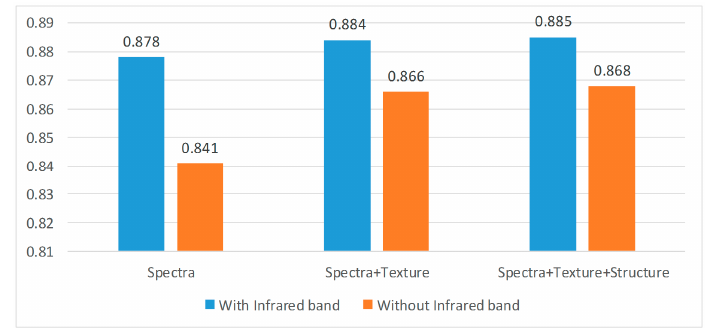
Figure 11. Average Kappa of 172 Landsat ETM+ images with different feature combination.